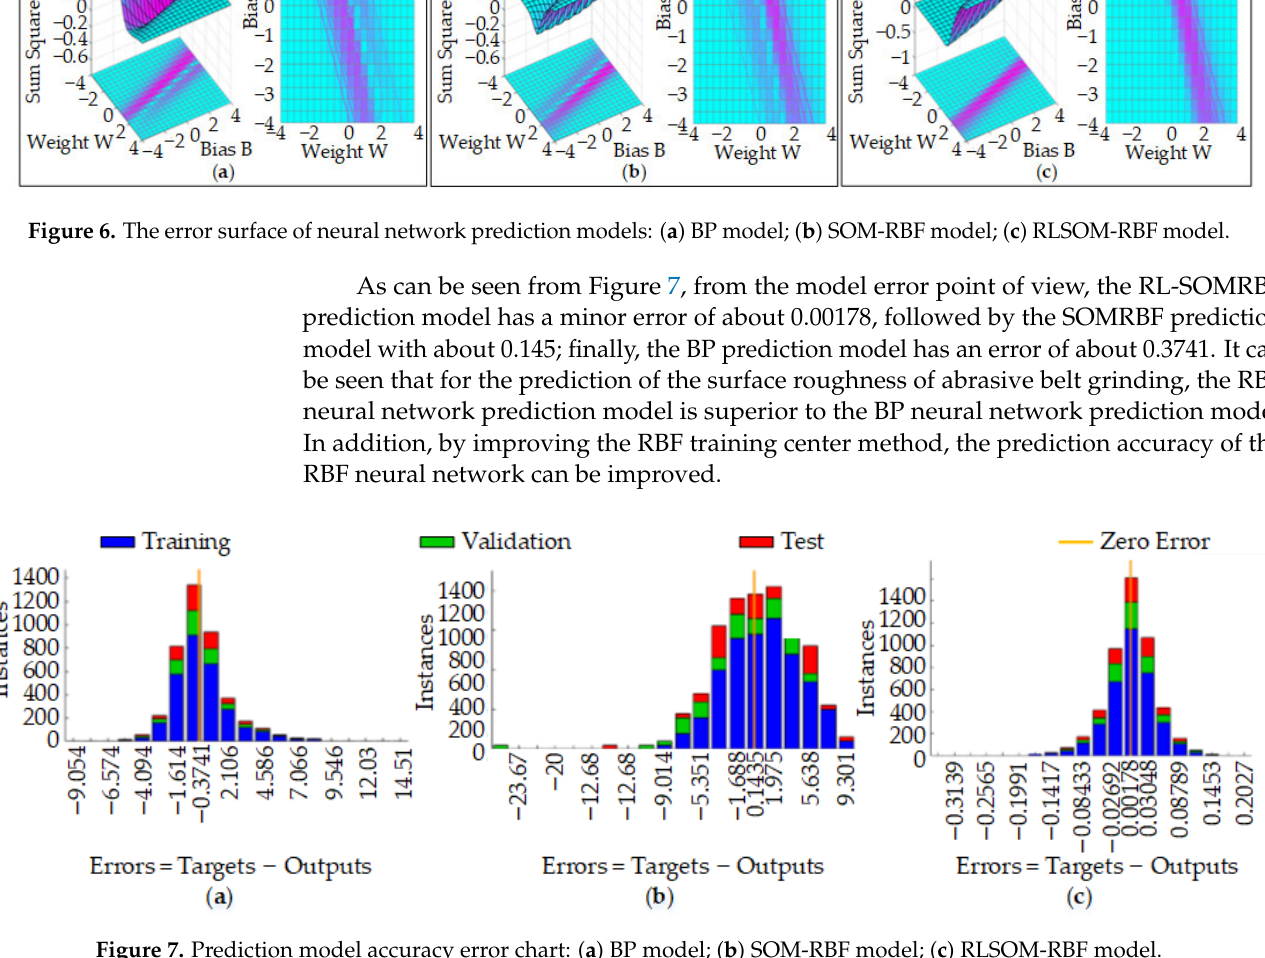
Figure 7. Prediction model accuracy error chart: ( a ) BP model; ( b ) SOM-RBF model; ( c ) RLSOM-RBF model.